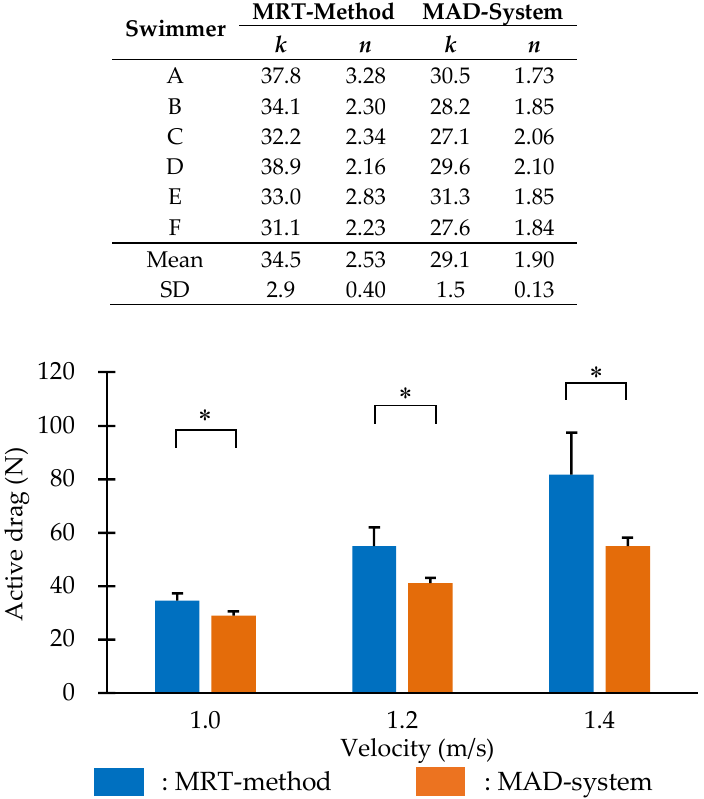
Table 1. Coefficient k and degree n in each swimmer obtained by MRT-method and MAD-system.